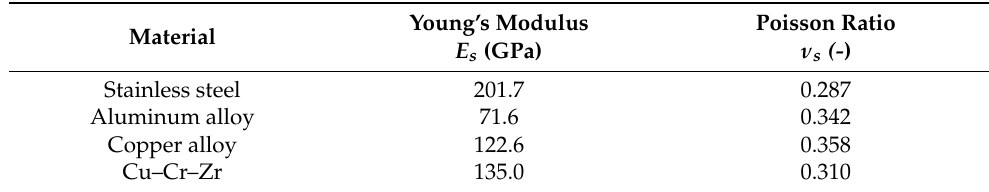
Table 1. Experimental values of the Young’s moduli and Poisson ratios of metals and alloys under investigation.